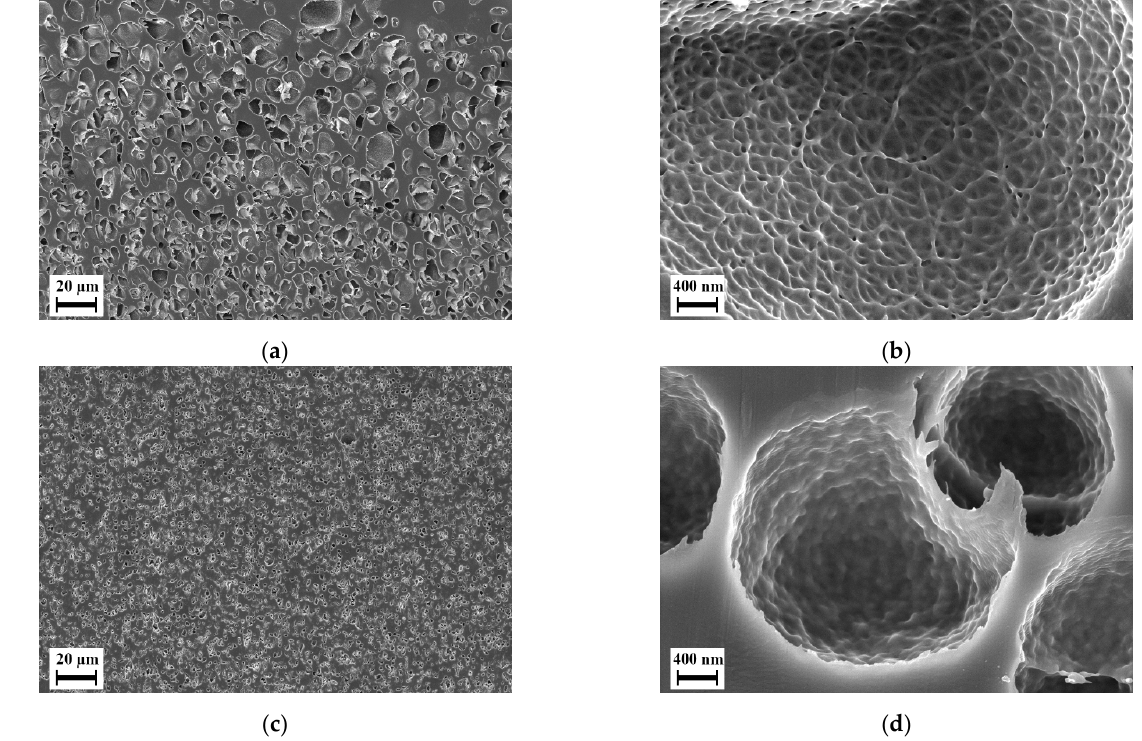
Figure 6. Scanning electron micrographs of selected foams manufactured using foaming agent CO 2 : ( a , b ) Blend L-8; ( c , d ) Blend H-8.